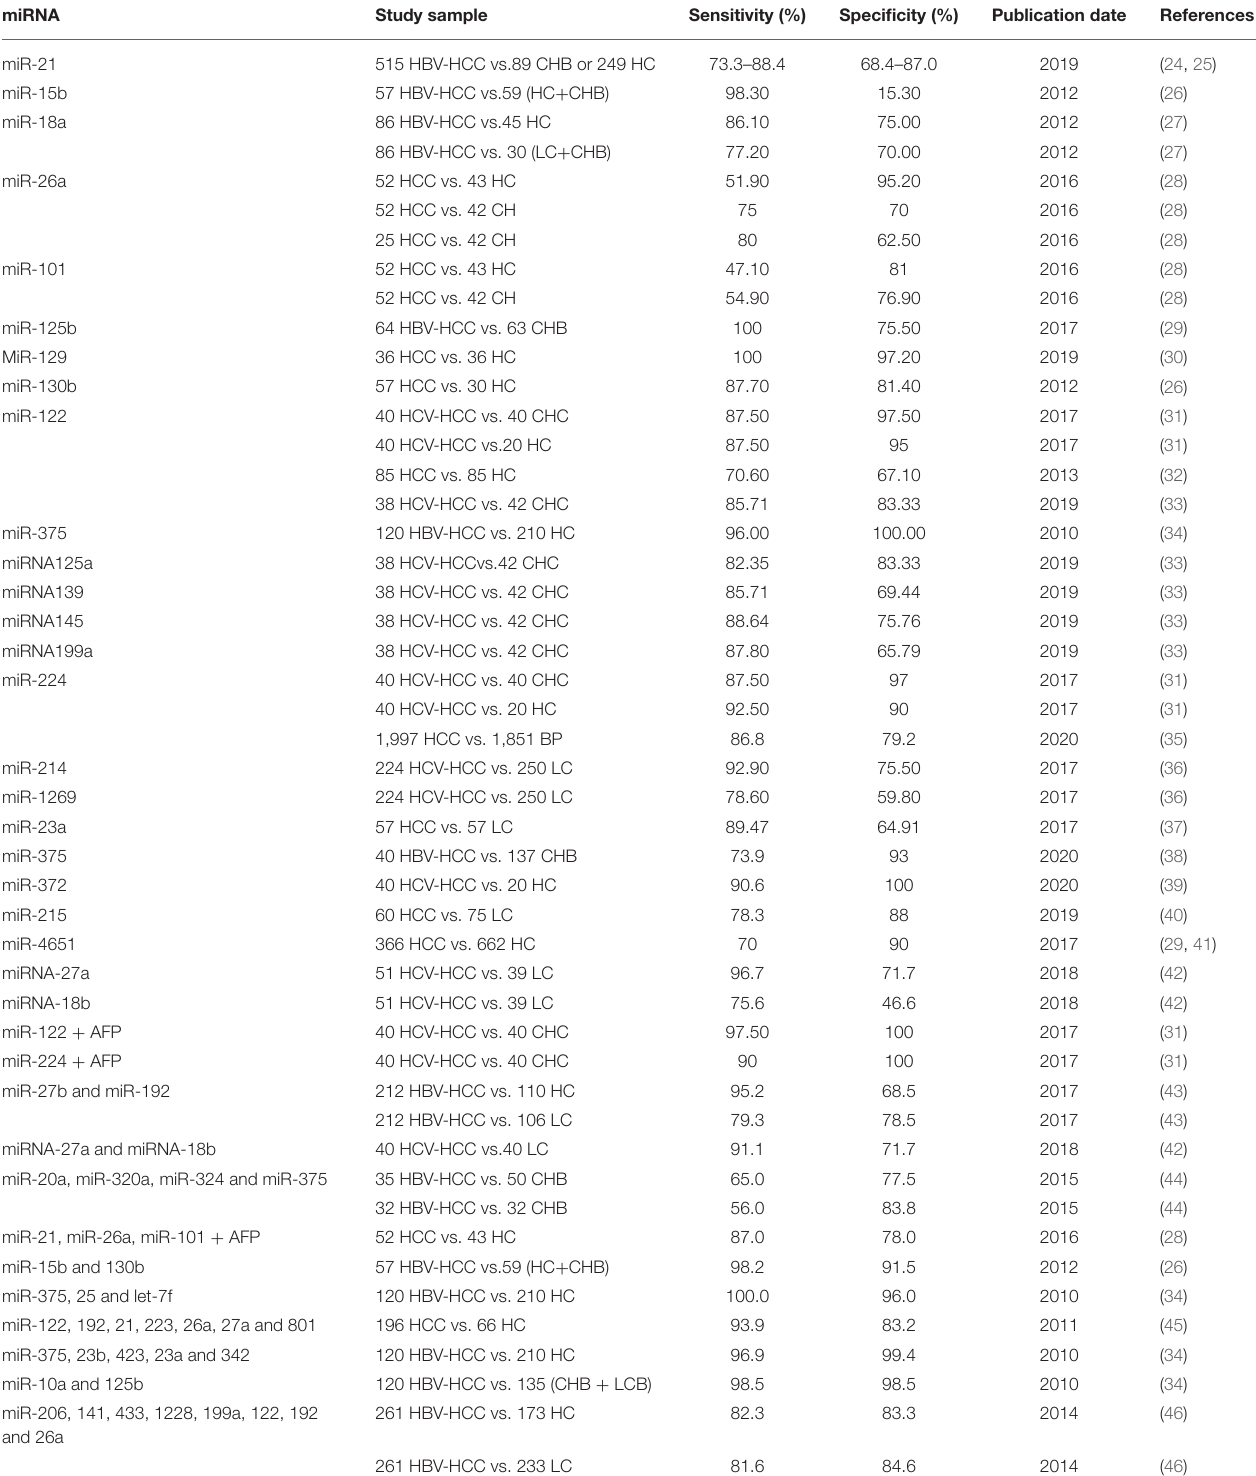
TABLE 1 | Sensitivity and specificity of selected studies and blood biomarkers for detecting hepatocellular carcinoma. miRNA Study